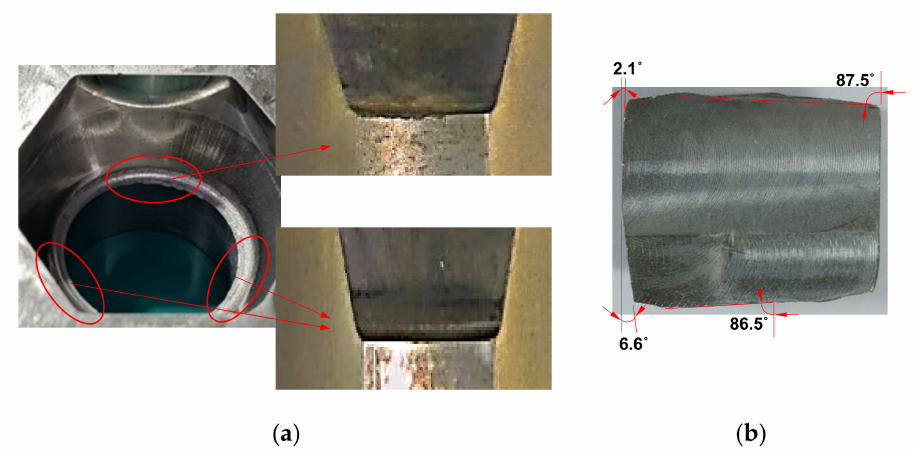
Figure 14. Non-symmetry of the process in terms of HCF fracture: ( a ) Unsymmetric HCF fracture of die insert; ( b ) Initial